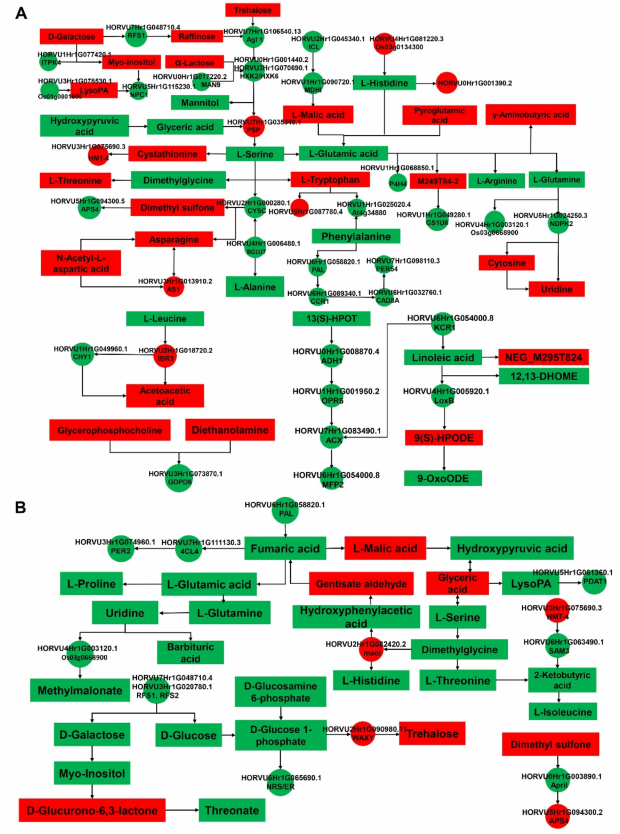
Figure 7. Biological response pathways of GN2 ( A ) and GN18 ( B ) seeds in response to salt stress. Correlation analysis results of DEPs and DAMs were mapped into a comprehensive metabolic regulation network diagram based on the KEGG pathway. The DEPs and DAMs are marked as circles and rectangles, respectively; red and green indicate upregulation and downregulation,